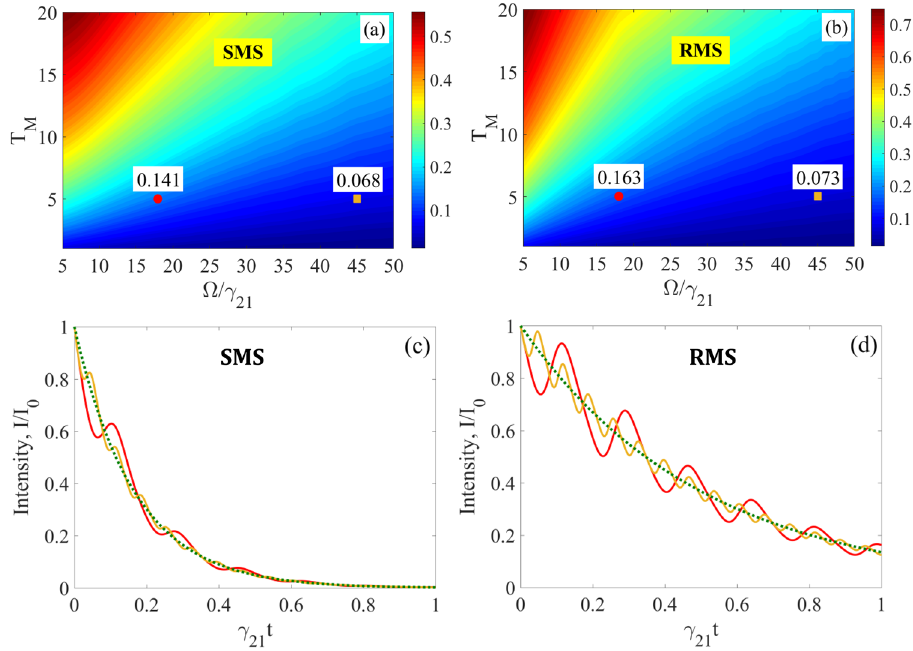
2 � , T M , π plotted according to Eqs. (24) and (12) at p S = γ 21 in (b) . In both panels ω SC = ω 21 and T e = (cid:30) (cid:29) (cid:31) 45 in (b) . The normalized photon waveforms 1 � = (cid:31) (cid:31)